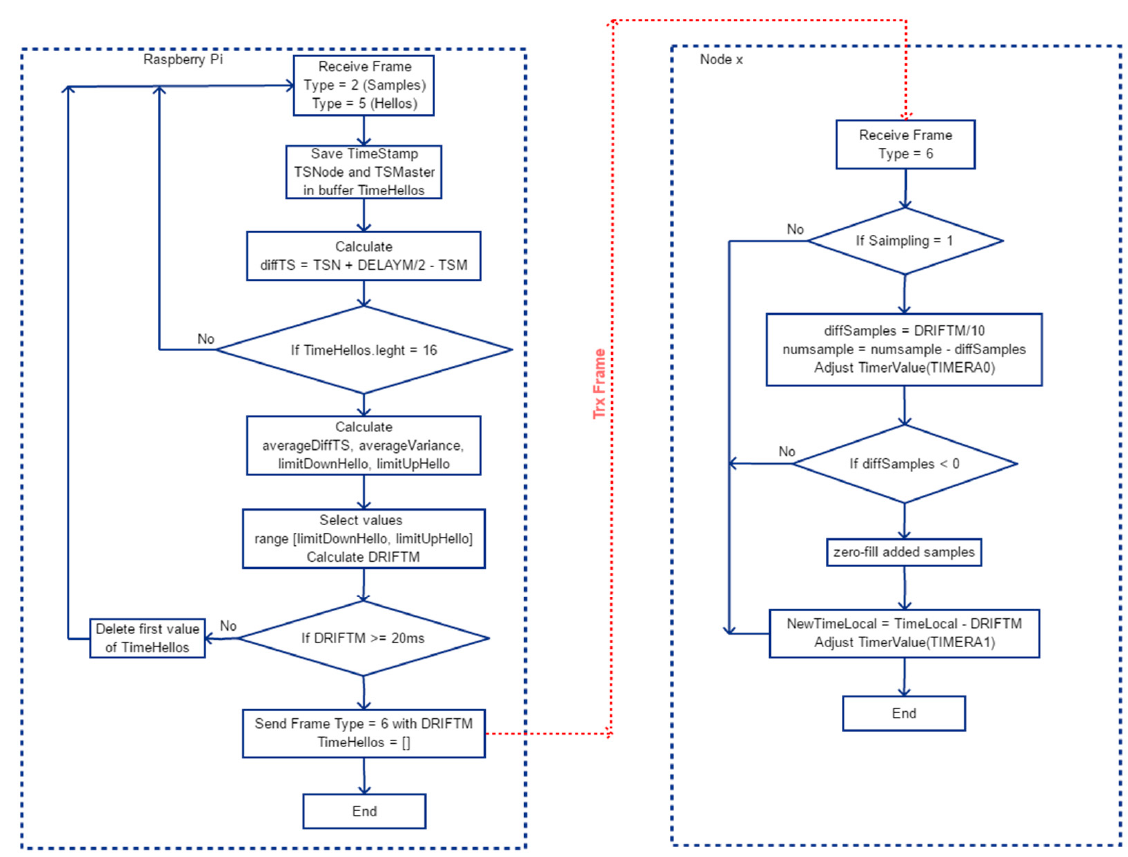
Figure 11. General flowchart of the drift algorithm in phase 2.